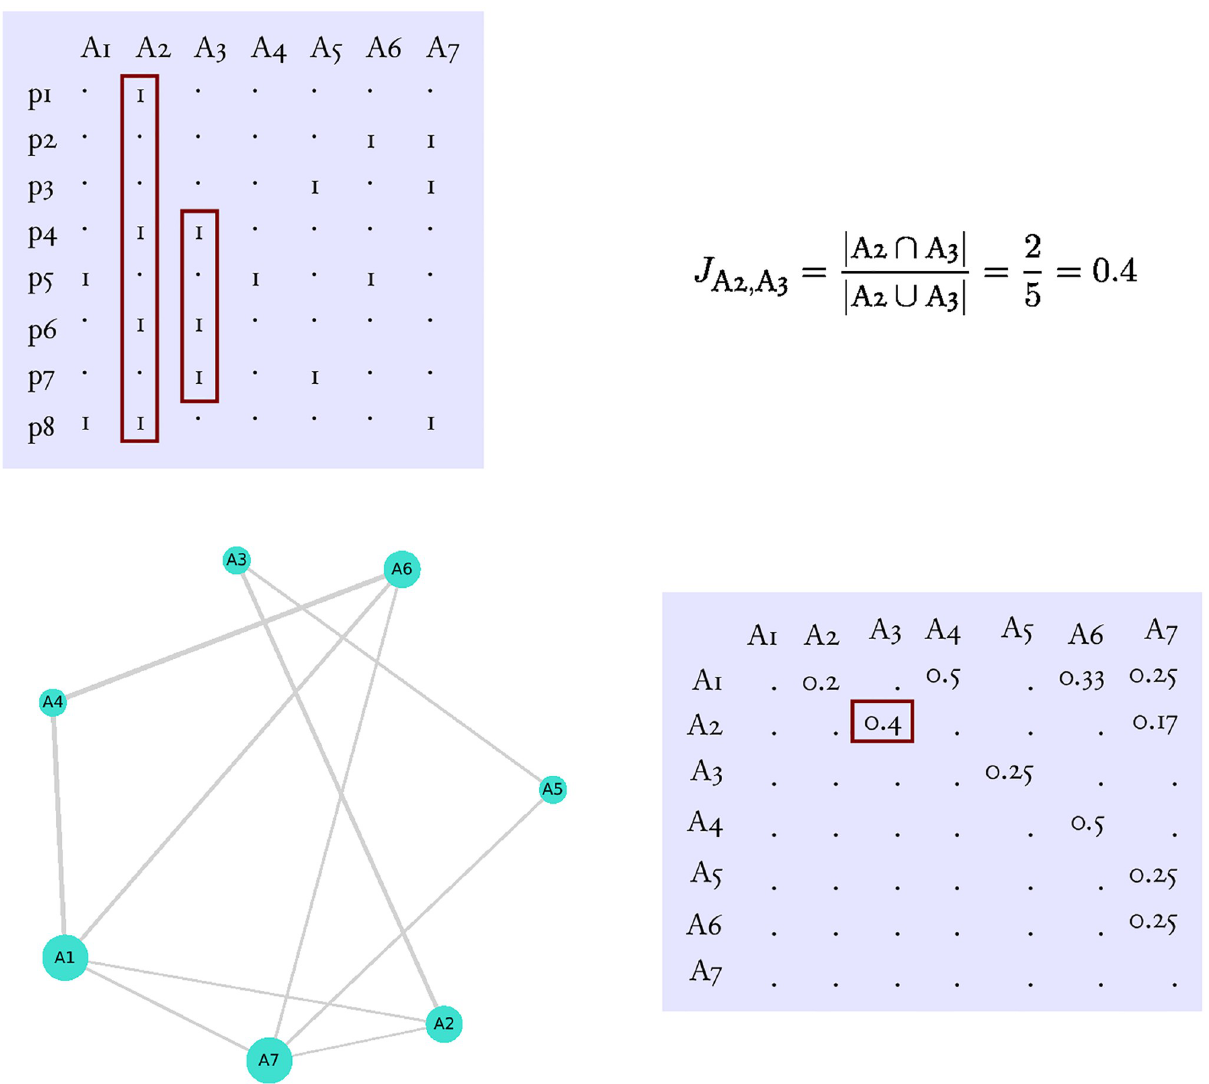
Fig 3. The construction of publication network. The top left panel shows the publication matrix, M . Each row and column of this matrix represents a P paper and an author, respectively. Values of 1 indicate that an author is on the author list of a given paper, while dots symbolise zeros. From the publication matrix one can derive the collaboration matrix, M (bottom right panel) by calculating the Jaccard simmilarity (top right) for each possible C pairs of authors. The bottom left panel shows the resulting weighted, undirected collaboration graph, G . Node size is proportional to the number of C coauthors (degree), while edge width shows the strength of the connection between two authors (i.e. it is proportional to their Jaccard similarity). The red rectangles in the matrices exemplify the calculation of Jaccar